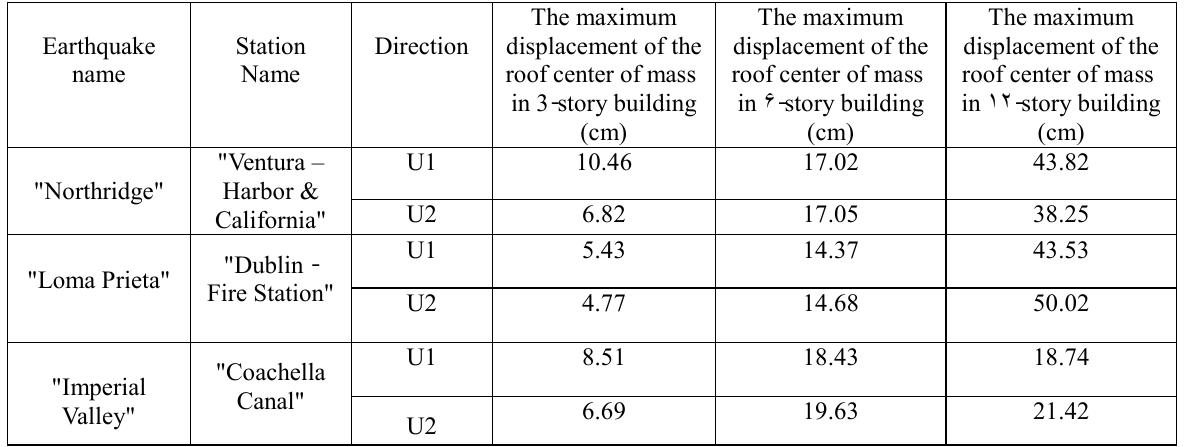
The maximum displacement of the roof center of mass in 3, 6 and 12-story buildings